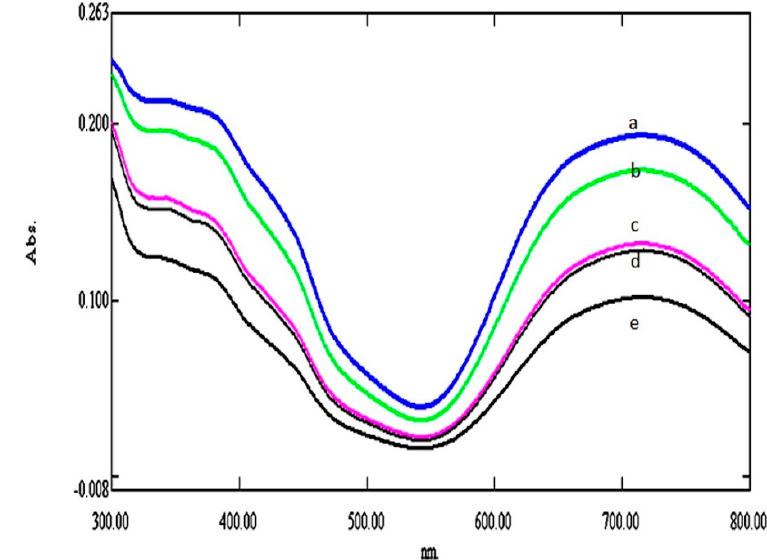
Figure 13. Absorbance spectra of acid green dyes after 1 h in dark in presence of ( a ) standard sample, ( b ) Zn-Al-GO3, ( c ), Zn-Al-GO2, ( d ) Zn-Al LDH and ( e )